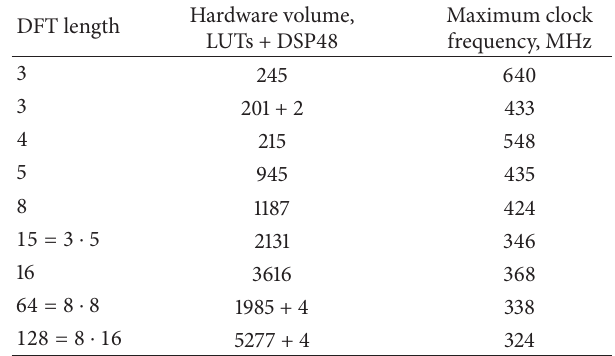
Table 1: Results of configuration of the DFT